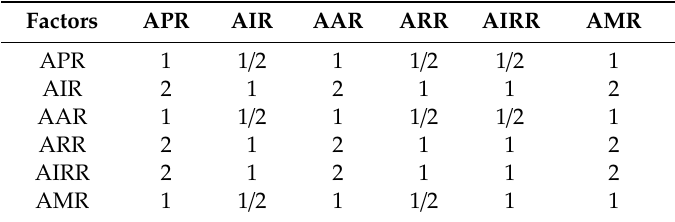
Table 10. Key decision factors pairwise comparison concerning the VP’s